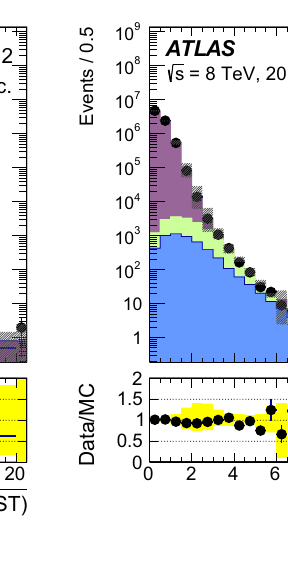
with intrinsic E miss (e.g. t ¯ t and dibosons) and those with T (e.g. poorly measured Z → μμ events with a fake E miss T large number of